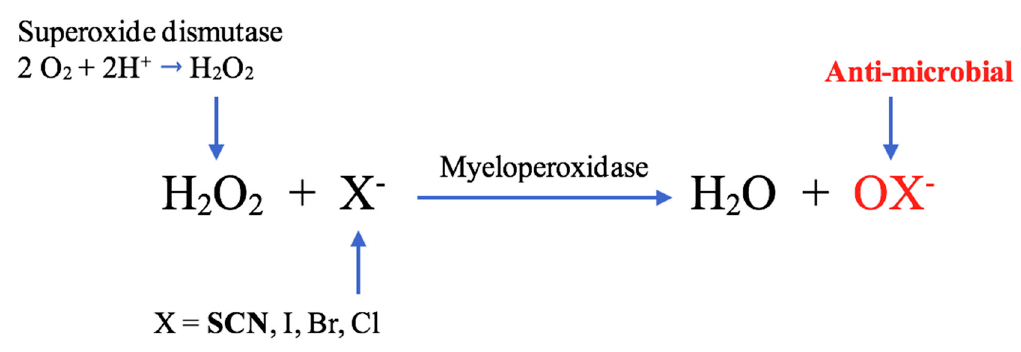
Figure 3. Myeloperoxidase (MPO) ‐ mediated formation of oxidation products, including hypothiocyanous acid (HOSCN), HOI, hypobromous acid (HOBr) and hypochlorous acid (HOCl) [41] .